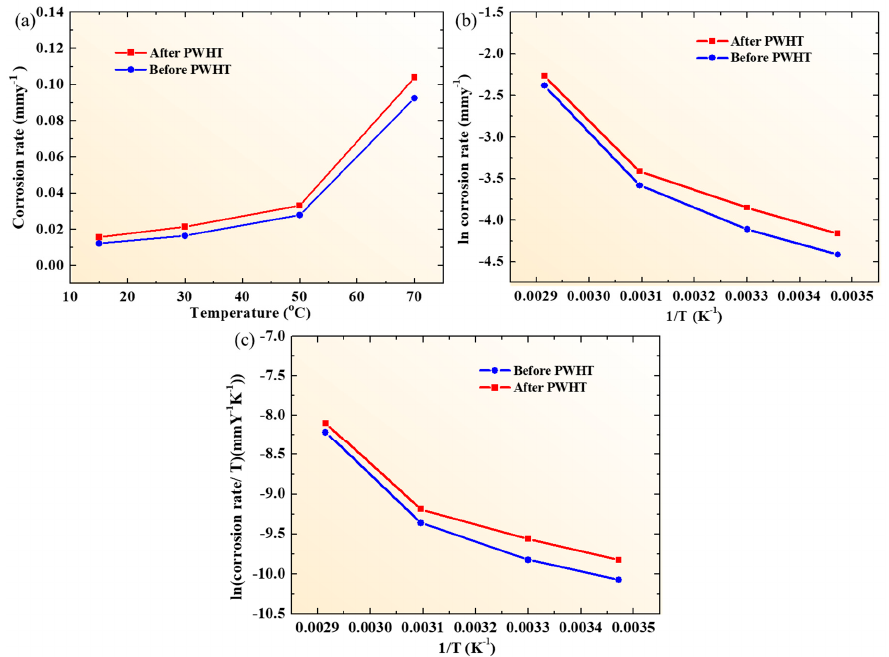
Figure 6. ( a ) Variation in corrosion rate with respect to solution temperature for weldment couple before and after the PWHT, ( b ) and ( c ) are the Arrhenius plot and ln ( υ corr /T) vs. 1/T for corrosion of weldment couple before and after the PWHT, respectively. Table 4. Activation parameters for butter weld samples before and after the PWHT.